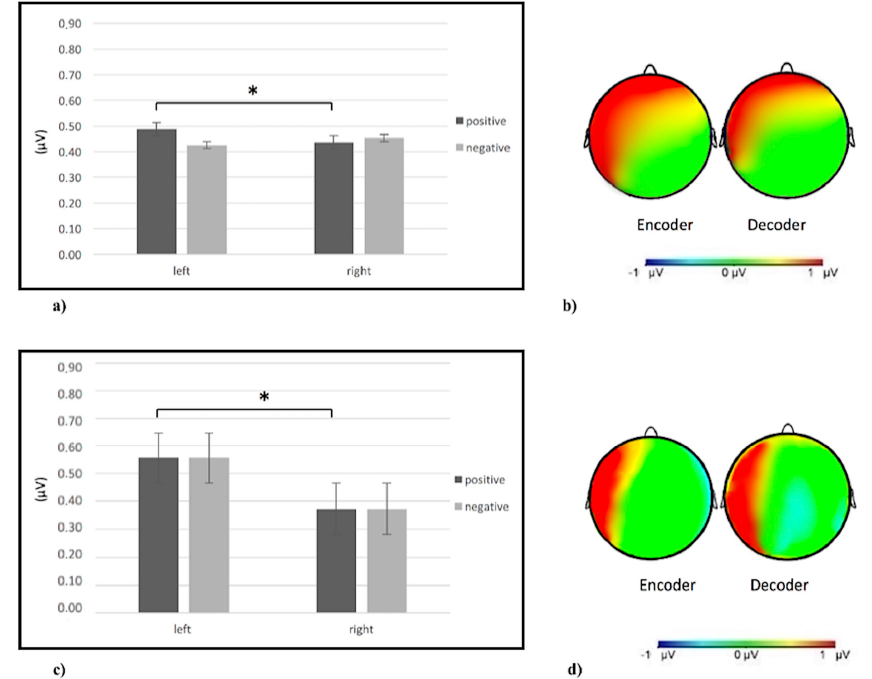
Figure 5. ( a ) Histogram of theta brain activity for positive and negative gestures in the left and right side. The figure shows an increase of theta power for positive gestures in the left side compared to the right one. Bars represent ∓ 1SE. Stars mark statistically significant ( p < 0.05) pairwise comparisons. ( b ) Theta inter-brain connectivity representation, from left to right, for positive gestures in the encoder and decoder. The red area represents an increase of theta inter-brain connectivity. ( c ) Histogram of beta brain activity for positive and negative gestures for the left and right side. The figure shows an increase of beta power for positive gestures for the left side compared to the right one. Bars represent ∓ 1SE. Stars mark statistically significant ( p < 0.05) pairwise comparisons. ( d ) Beta inter-brain connectivity representation, from left to right, for positive gestures in the encoder and decoder. The red area represents the increase of beta inter-brain